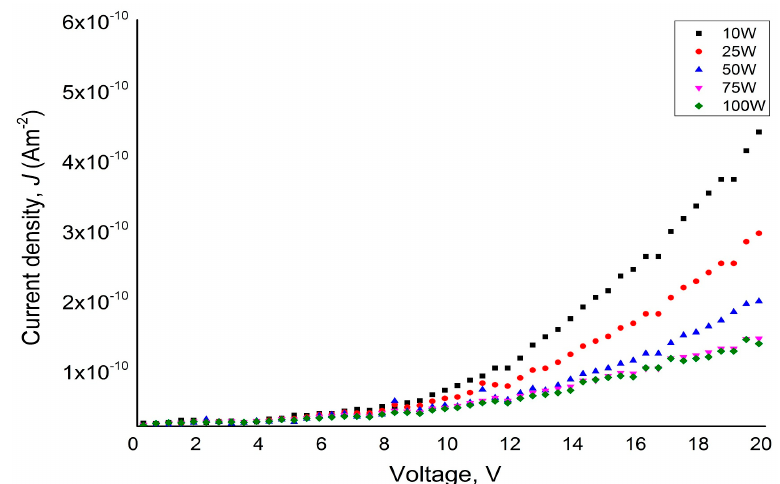
Figure 5. Current density ( J ) of pelargonium plasma polymer thin films with an applied voltage ( V ) between 0 and 20 V.